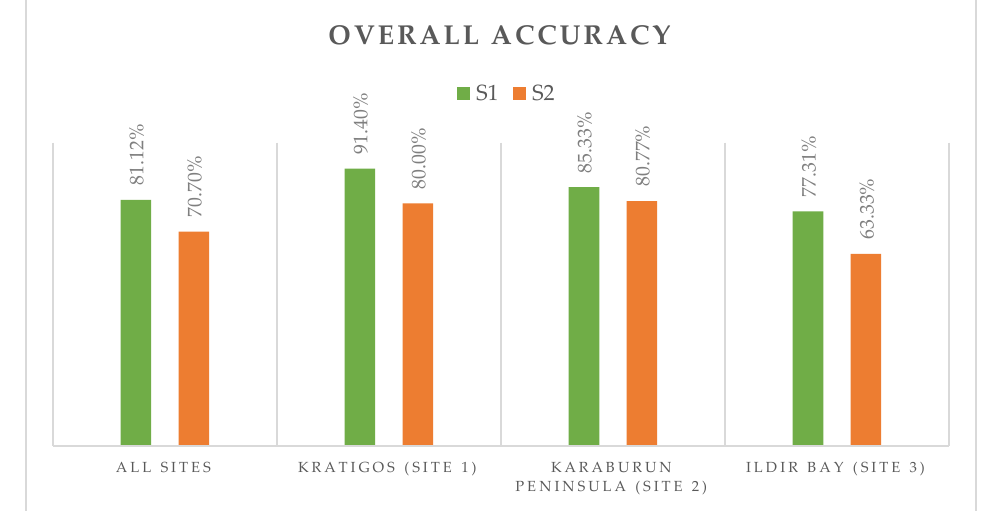
Figure 8. Overall accuracy of the two datasets.